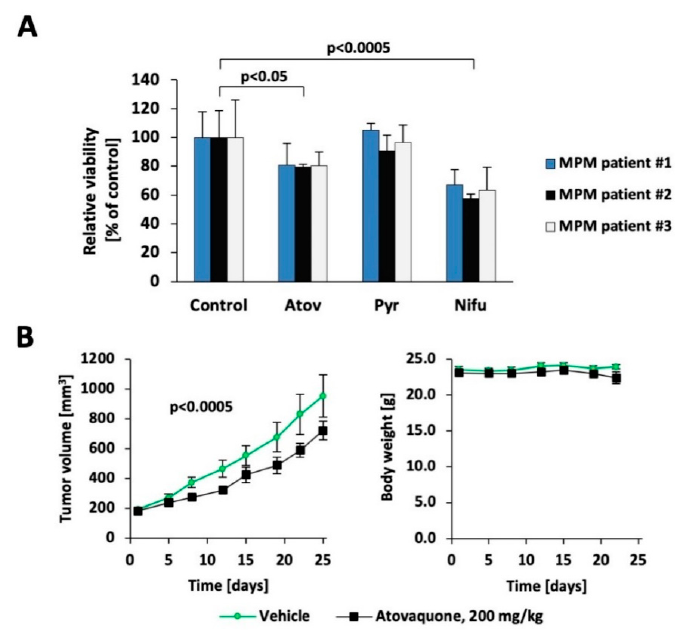
Figure 3. Targeting the STAT3 pathway in preclinical models of MPM. ( A ) Freshly isolated MPM patient spheroids of patient #1 and patient #3 were treated for 3d with 80 μ M atovaquone, 6 μ M pyrimethamine, 40 µ M nifuroxazide or vehicle; patient specimen #2 received half the concentration. Changes in treatment groups were compared to their respective controls ( n = 3). ( B ) Mice implanted with MS4 tumor fragments were treated with 200 mg/kg atovaquone or vehicle. Tumor volume and body weight were monitored.